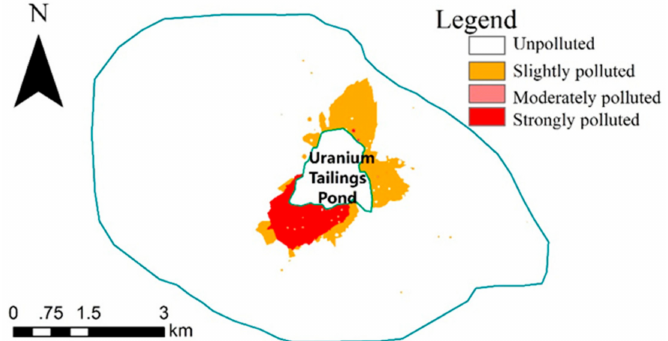
Figure 5. The continuous distribution of U’s CF 2.